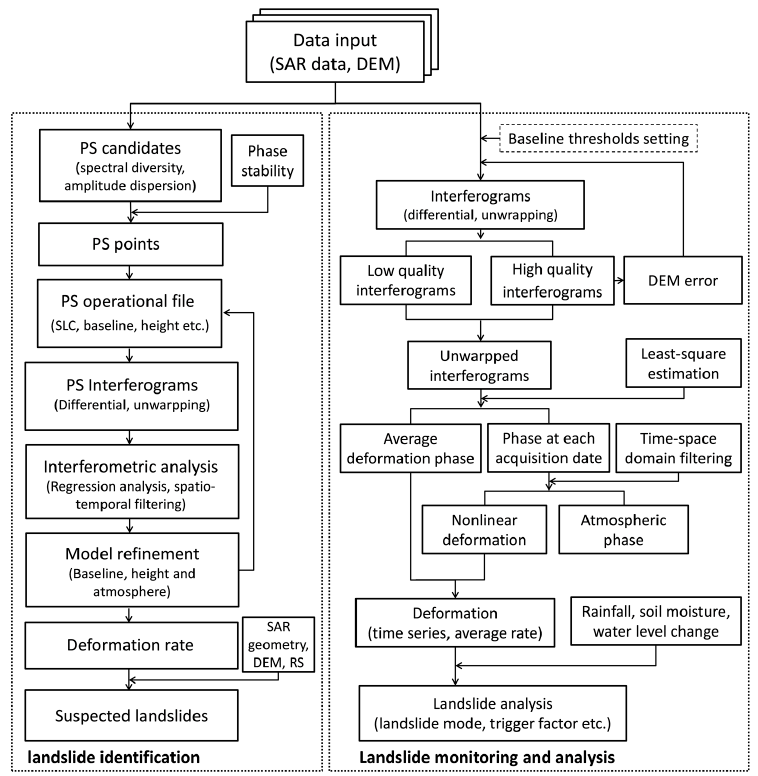
Figure 3. The flowchart of landslide identification and monitoring with InSAR methods. In the flowchart, PS stands for persistent scatterer, DEM is digital elevation model and RS means remote